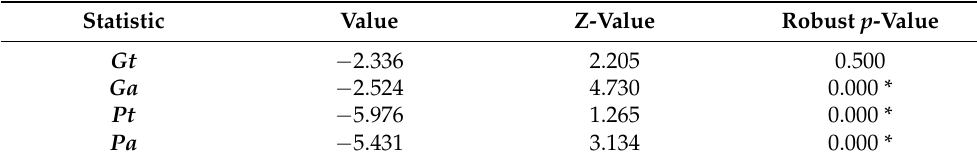
Table 4. Results of Westerlund [50] cointegration test.